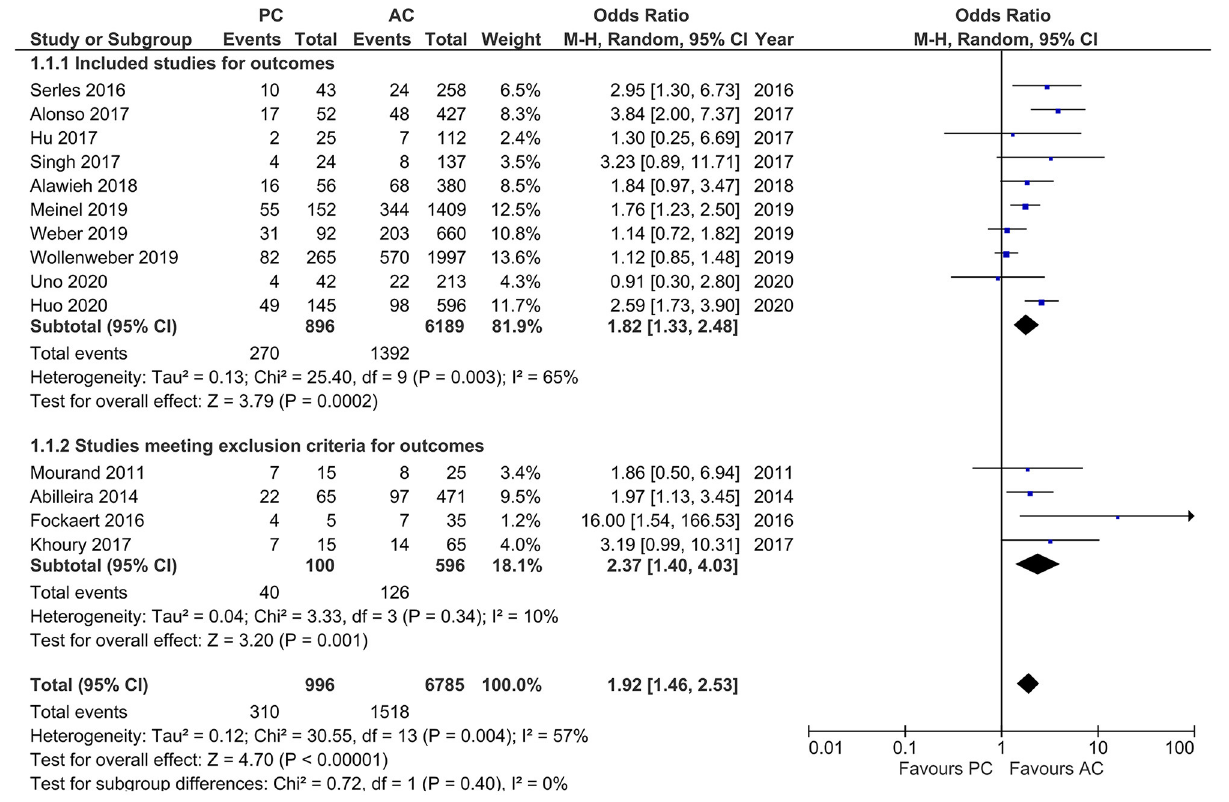
FIGURE 11 | Forest plot comparing “mortality at 90 days” in patients with large vessel occlusion (LVO) in the posterior circulation (PC) vs. anterior circulation (AC) who were treated with endovascular mechanical thrombectomy. Four studies with < 20 PCLVO patients and/or patient recruitment primarily until 2012 were excluded from subgroup analysis. Chi 2 , chi-square statistic; CI, confidence interval; df, degrees of freedom; I 2 , I -square heterogeneity statistic; M-H, Mantel–Haenszel statistic; P , p -value; Tau 2 , estimated variance of underlying effects across studies; Z , Z